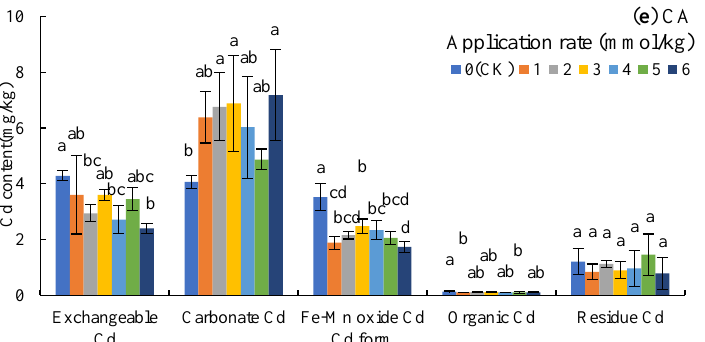
Figure 2. Cd content of different forms in the soil under LMWOA treatments and the CK; ( a ) oxalic acid (OA), ( b ) acetic acid (AA), ( c ) tartaric acid (TA), ( d ) malic acid (MA), and ( e ) citric acid (CA). Different lowercase letters show significant differences for p < 0.05.